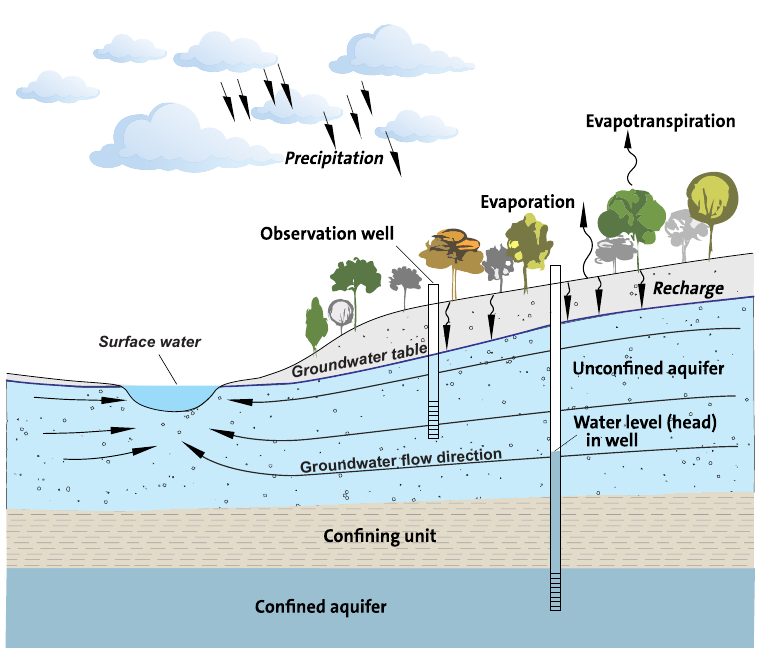
Figure 1. Cross-section of a typical groundwater flow system (modified from: